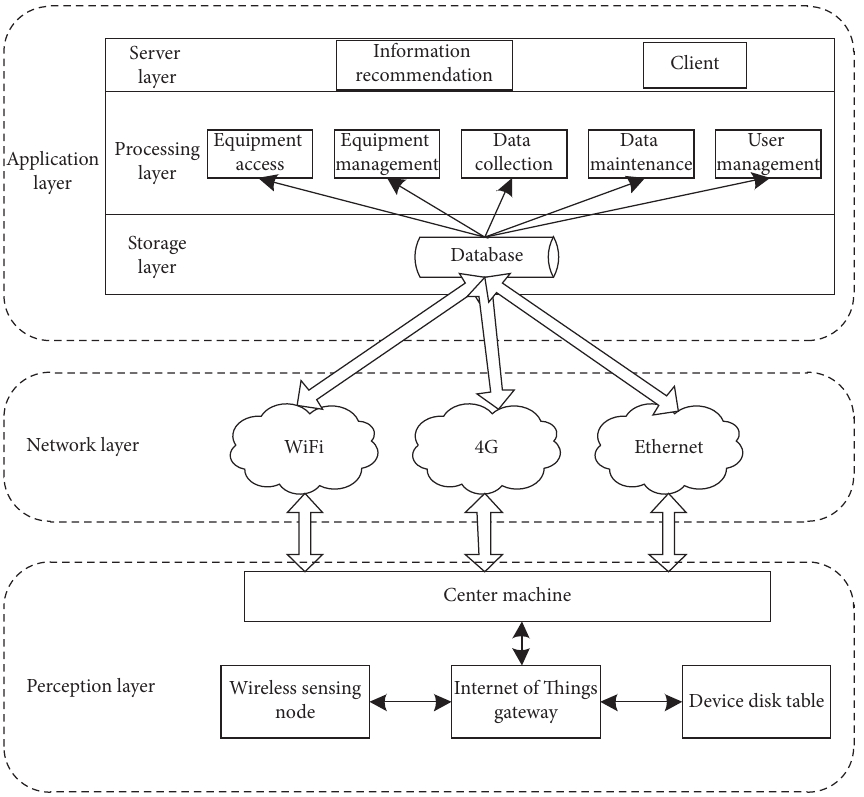
Figure 1: System structure diagram.